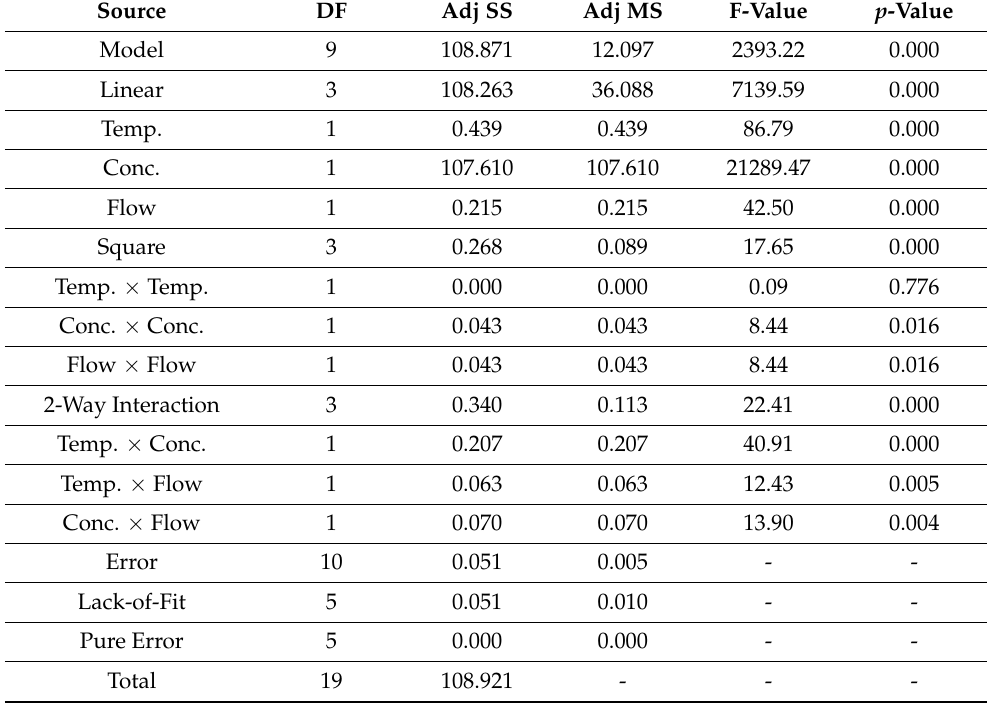
Table 5. Analysis of variance for benzene permeate flux.